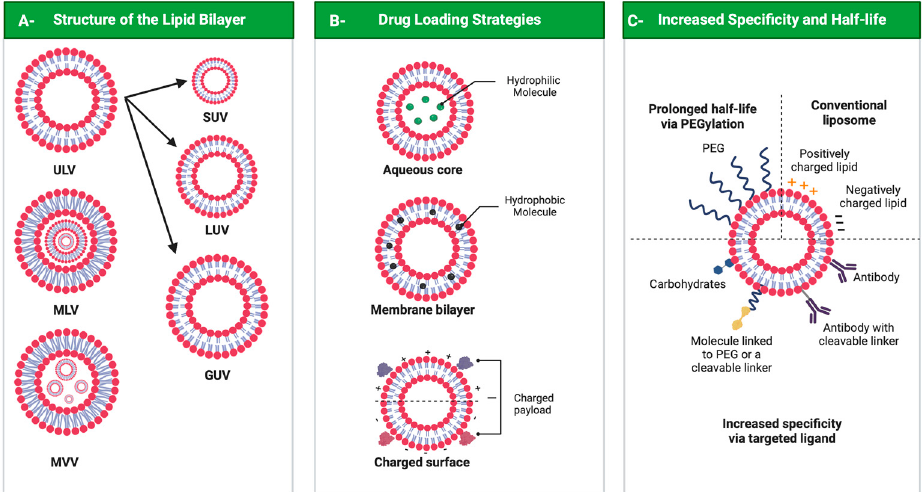
Figure 4. Liposomes. Panel A: Structure of liposomes. ULV—unilamellar vesicle (small ULV (SUV), large ULV (LUV) and giant ULV (GUV)); MLV—multilamellar vesicle; MVV—multivesicular vesicle. Panel B: Drug loading strategies. Panel C: Liposome surface and functionalization. All figures were drawn with BioRender accessed on 1 December 2022.